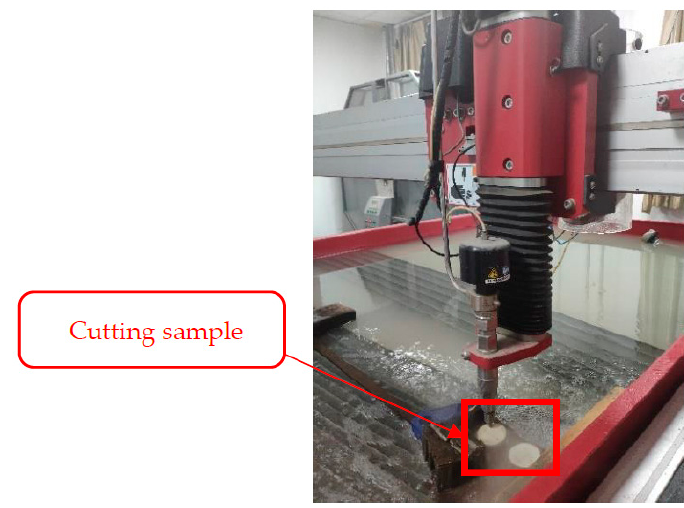
Figure 3. High-pressure waterjet.